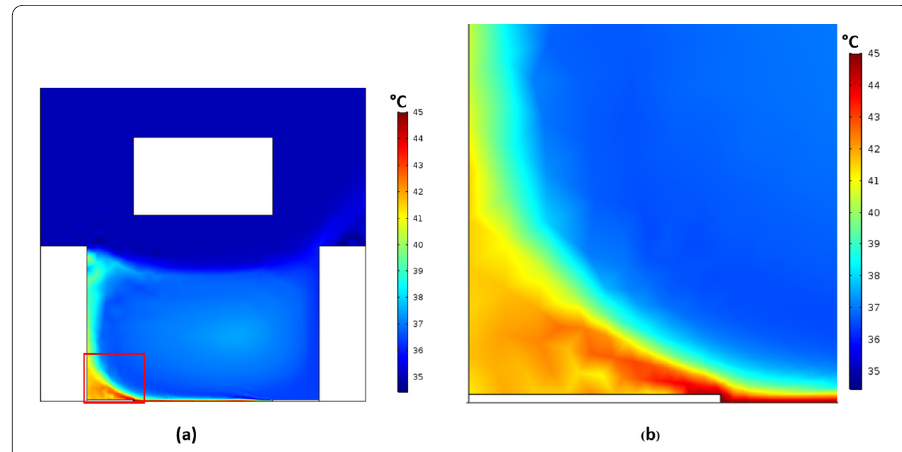
Figure 5 The surface temperature ( ° C) at steady state when u = 18 km/h (moderate wind): ( a ) Half of the entire computational domain, and ( b ) Zoom-in of the selected area